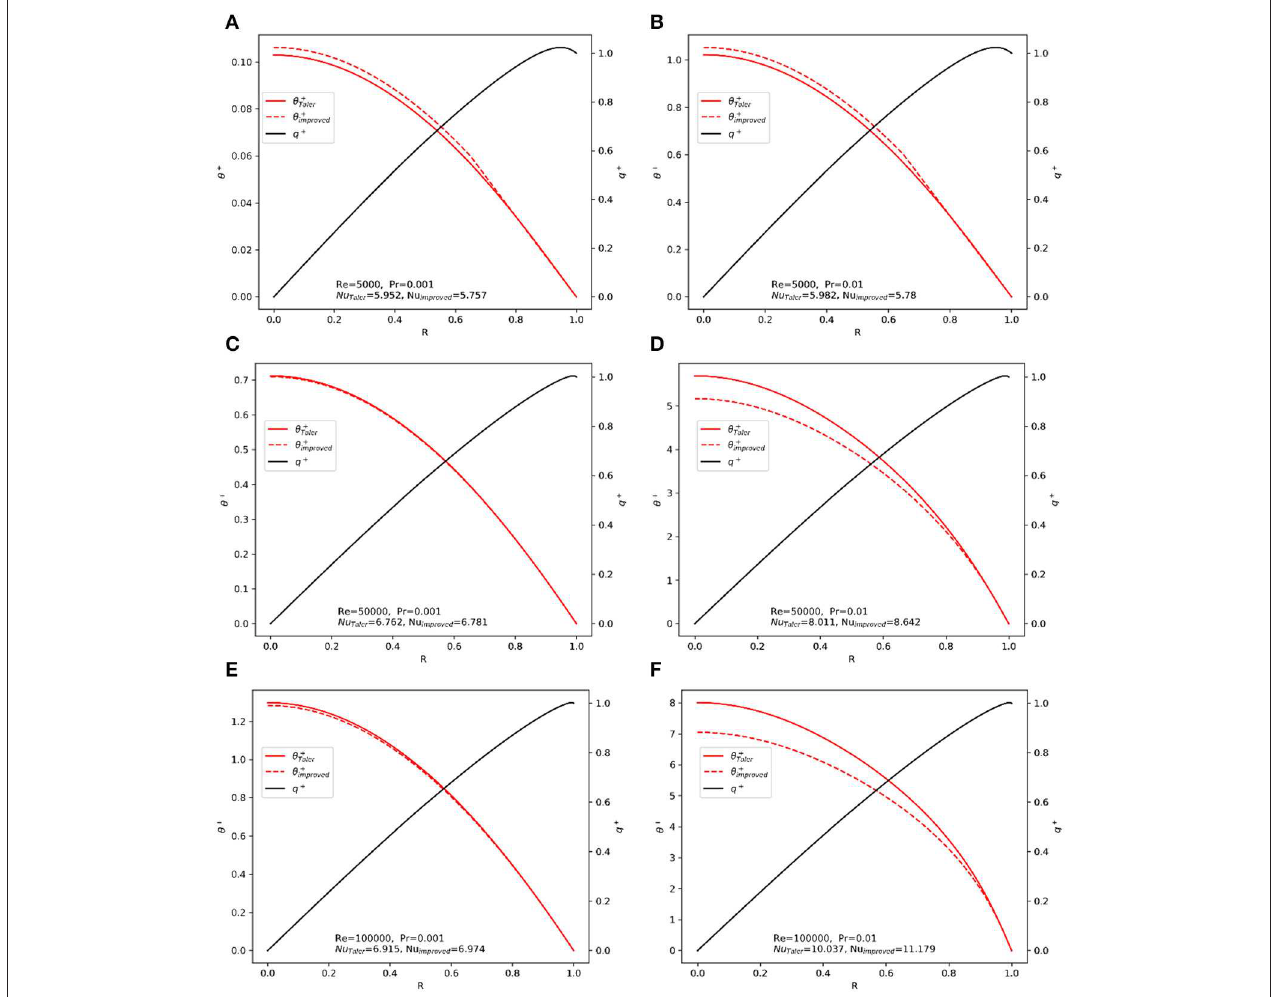
FIGURE 1 | (A–F) Non-dimensional heat flux and temperature along the radial direction.